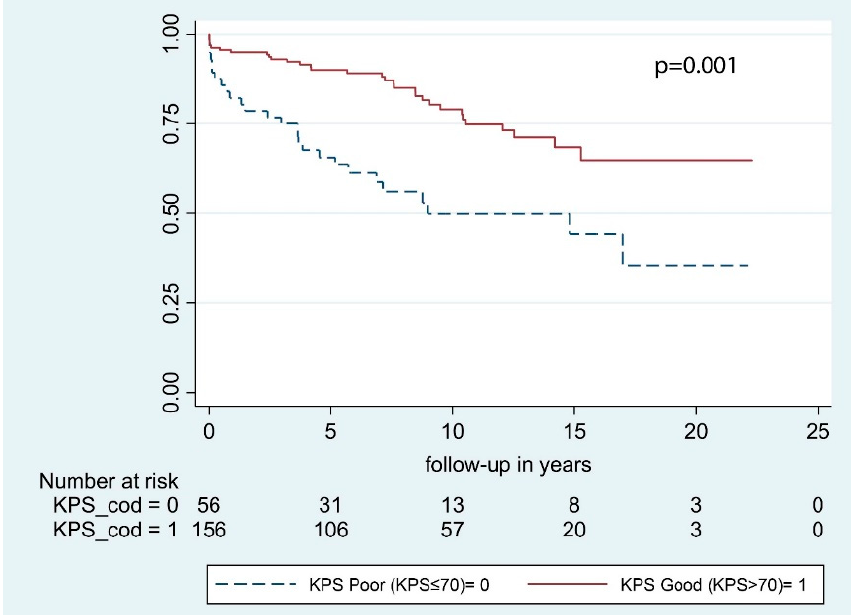
Figure 3. Overall survival by preoperative KPS.